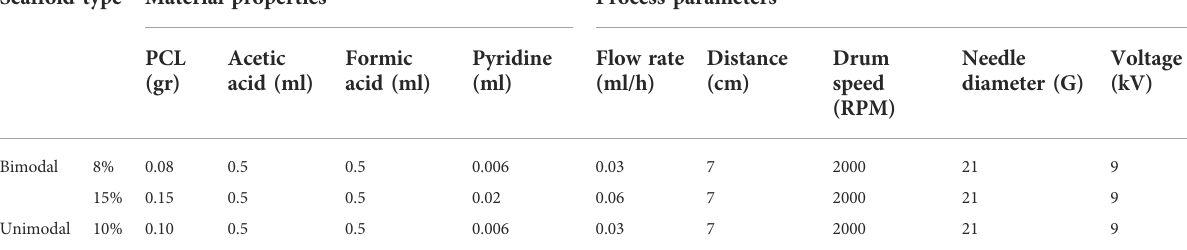
TABLE 1 Compositions and process parameters to prepare bimodal and unimodal constructs. Scaffold type Material